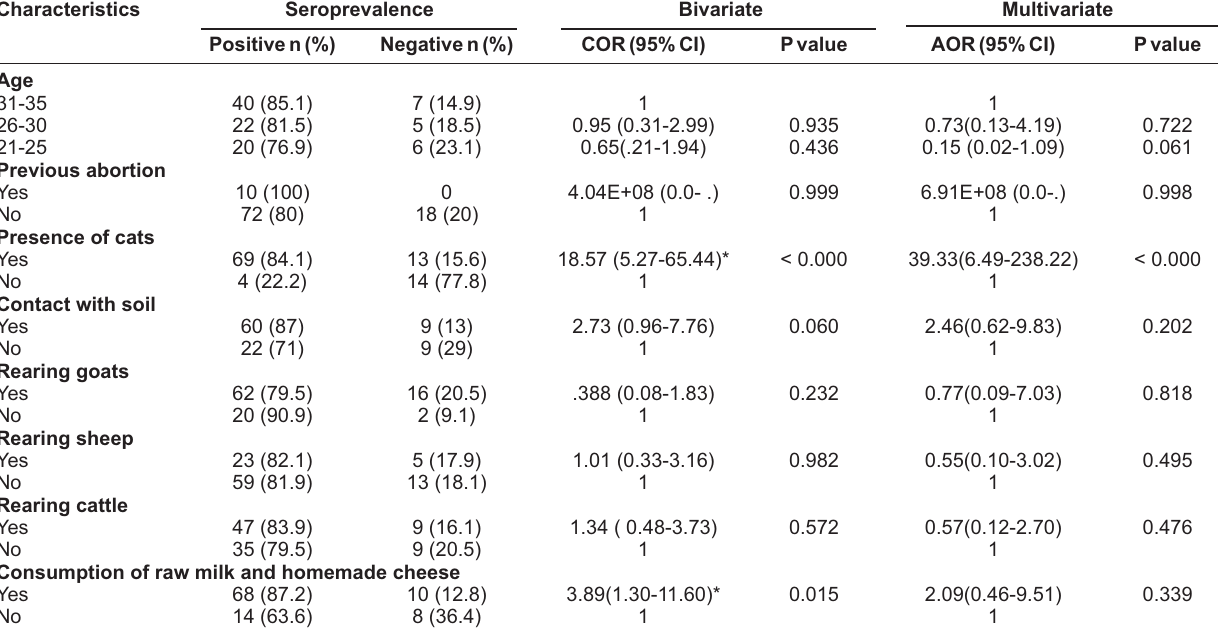
Figure-1: Agarose gel showing PCR results of gene amplification in the examined milk samples (L: 100 bp ladder, 1: B1 Positivecontrol,2:positivesheepmilksample,3,4,9:negativesamples,5-8:positivegoatmilksamples,10:Negativecontrol). Table-2: Factors associated with seroprevalence in pregnant women T. gondii